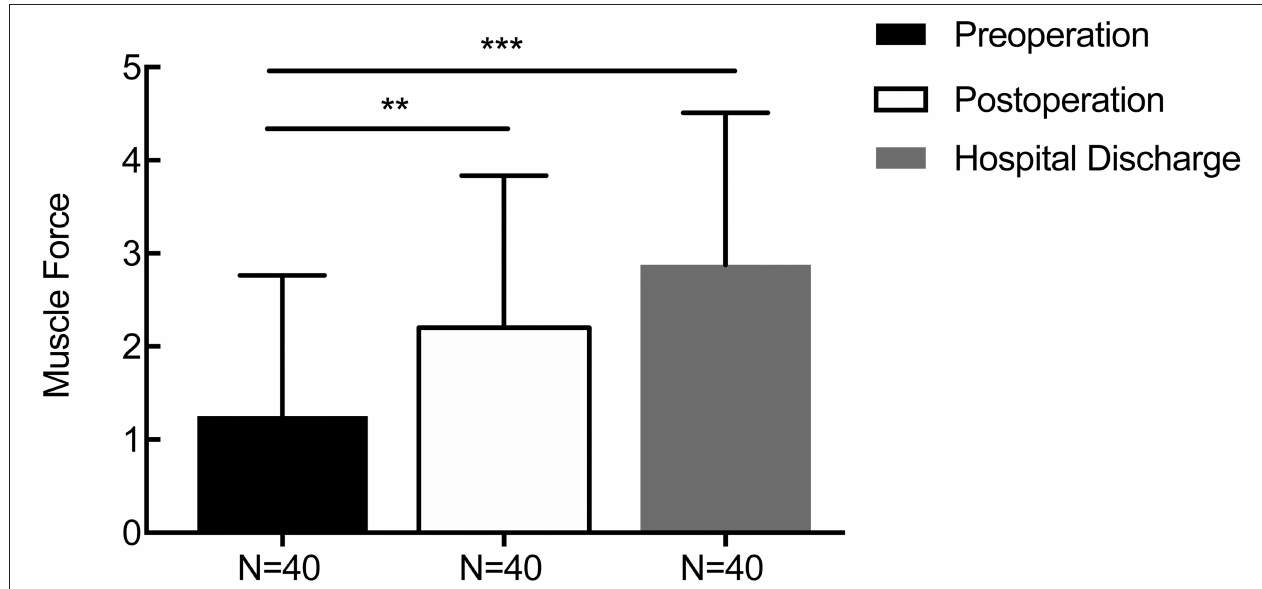
FIGURE 7 | Changes in the perioperative muscle force score. The average preoperative muscle power was 1.25 ± 1.51, and the mean muscle power at 1 week after the operation and discharge time were 2.20 ± 1.64 ( p = 0.009) and 2.88 ± 1.64 ( p < 0.001), respectively. ** p < 0.01 and *** p < 0.001.